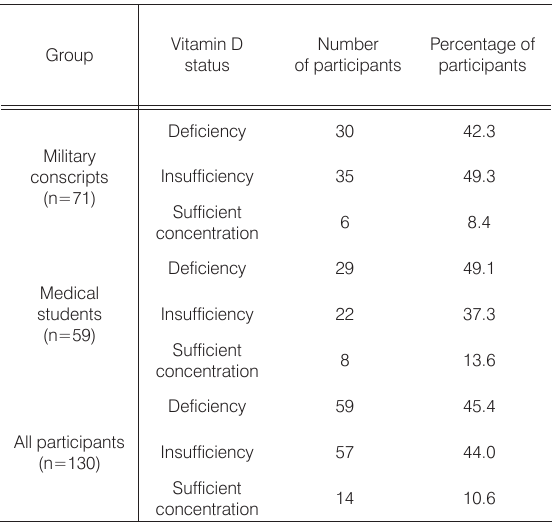
Table 2 Distribution of military conscripts, medical students, and all participants by vitamin D status